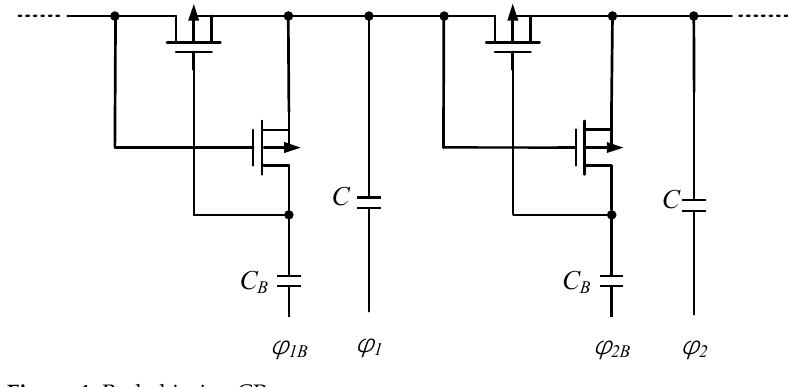
Figure 4. Body biasing CP.